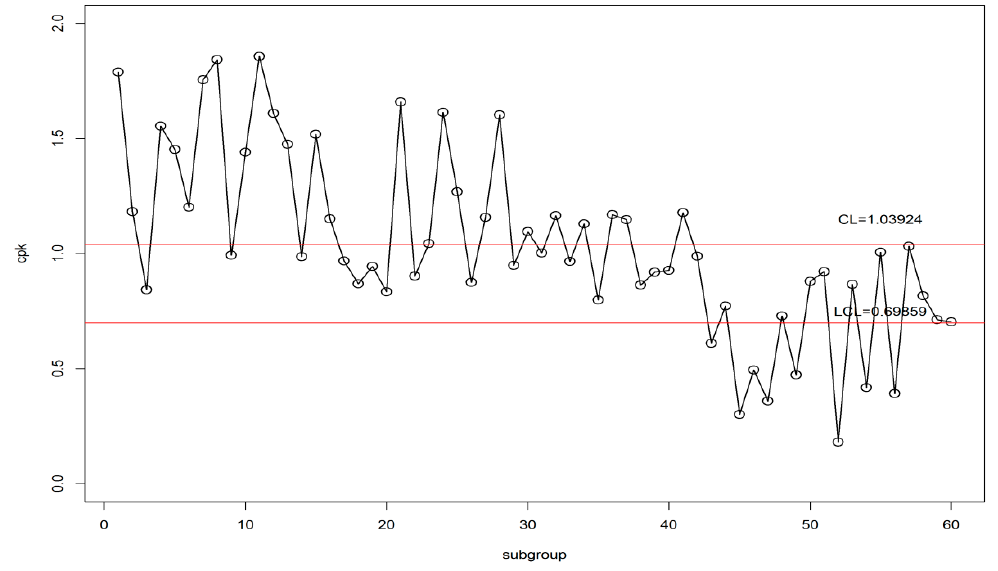
Figure 1. Proposed Weibull median absolute deviation (MAD) control chart for simulated data.